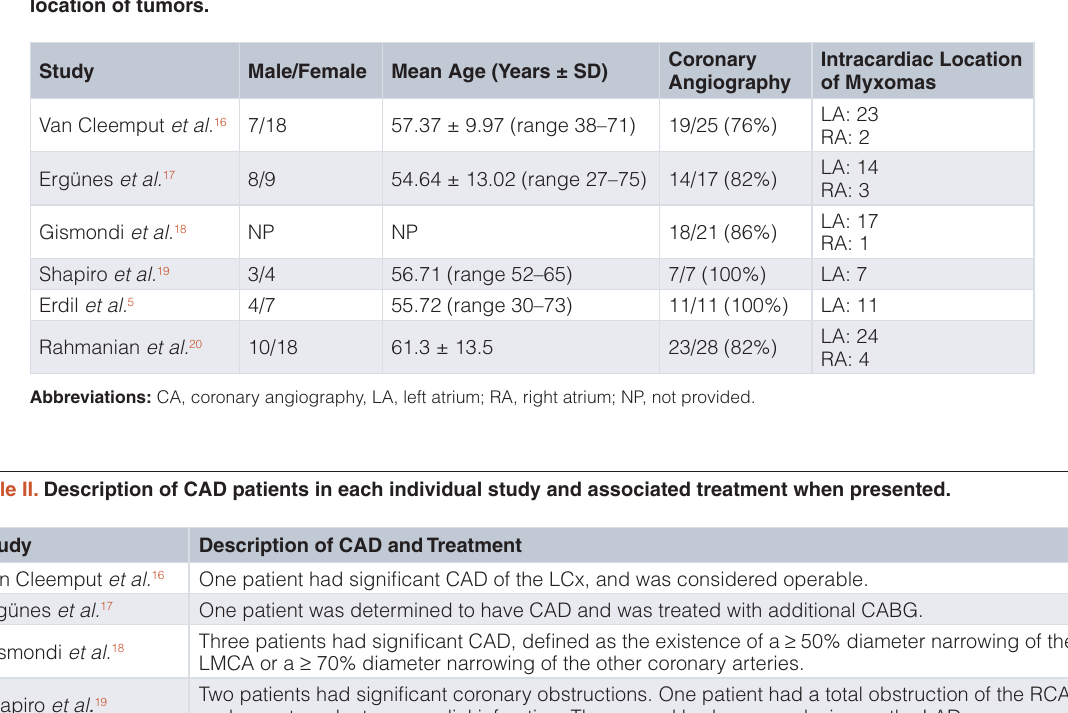
Table I. Demographic characteristics of study populations, proportion of patients who underwent CA and location of tumors.